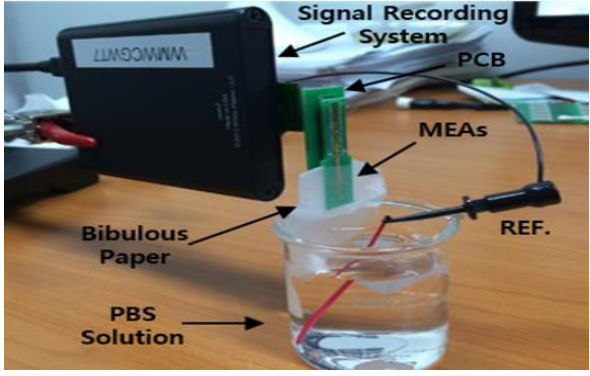
Figure 5. Measurement setup of the assembled MEAs.